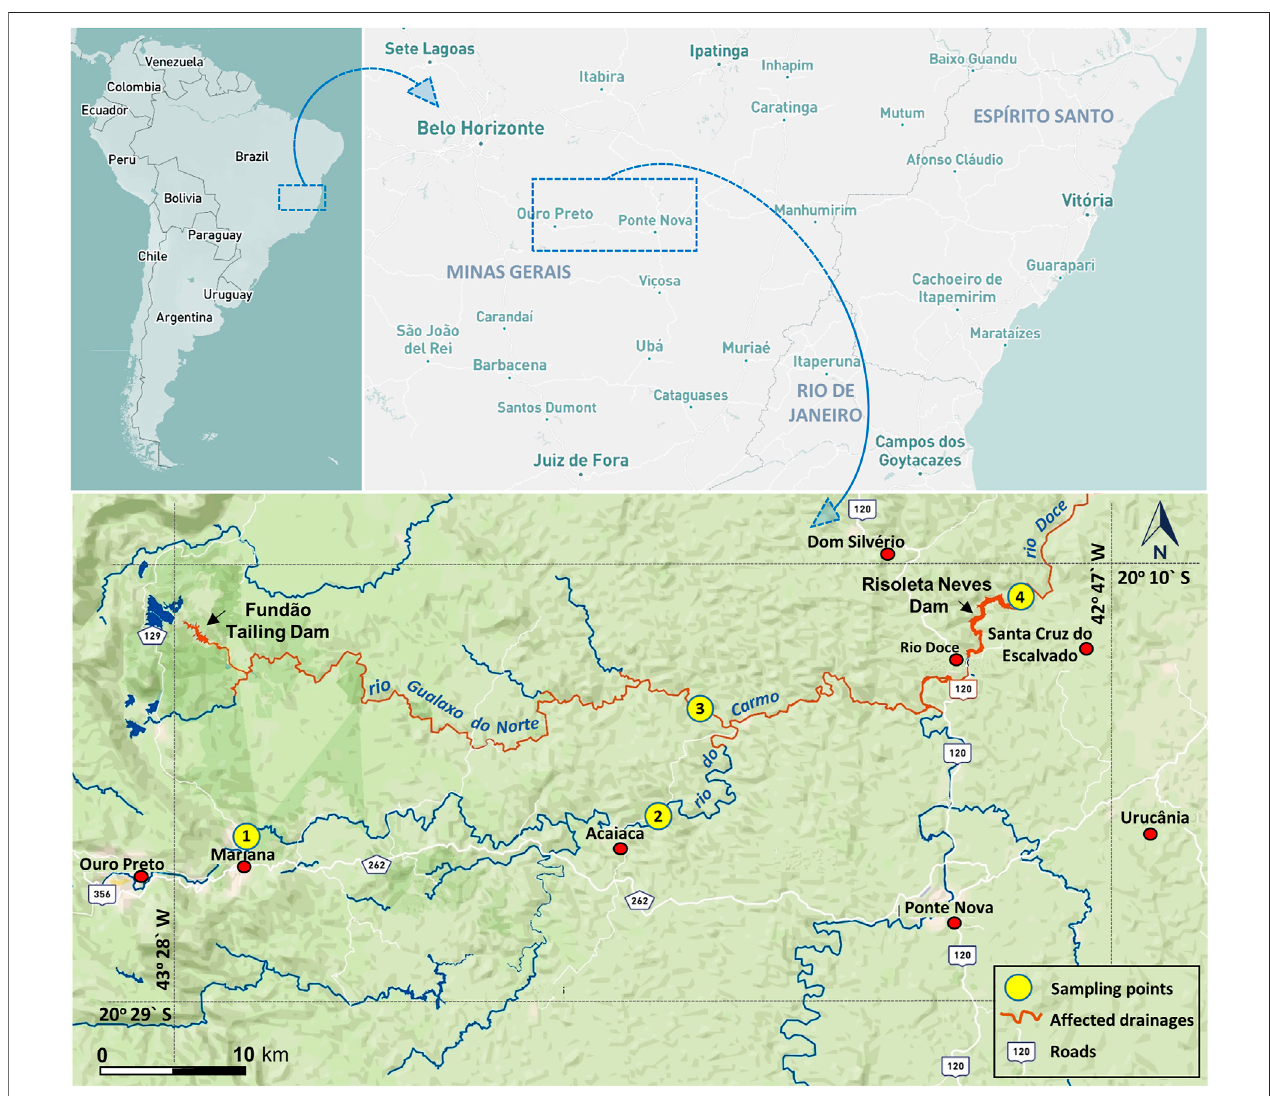
FIGURE1| SamplingsitesalongtheRioDocewatershed,MinasGerais,Brazil.Site1intheCarmoRiverintheMarianadistrict,characterizedbyurbandischarges; Site 2 in the Carmo River near its surrounding agricultural fi elds (mainly extensive cattle ranching and eucalyptus plantations); Site 3 in the Gualaxo do Norte River, surrounded by agricultural fi elds (mainly arable), into which wastewater in SAMARCO iron ore mining; and Site 4 in the Doce river which is formed by the junction of the Piranga and Carmo Rivers, also receiving urban discharges from the city of Ponte Nova through the Piranga River.